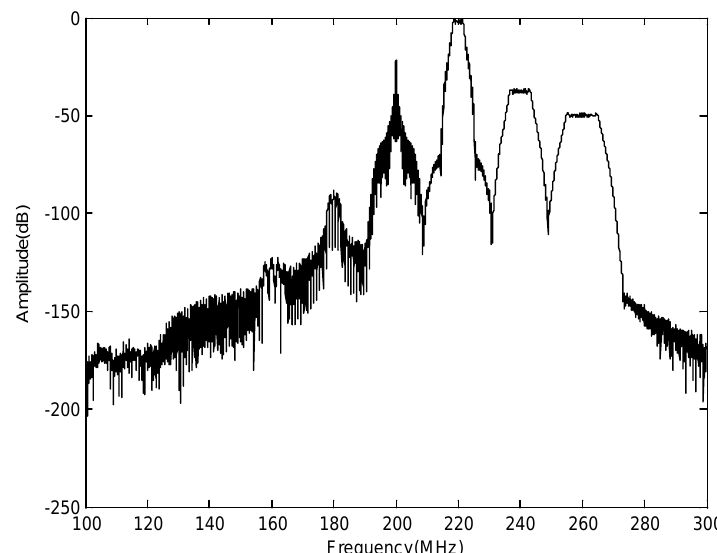
Figure 15. Frequency spectrum of mixer output signal.